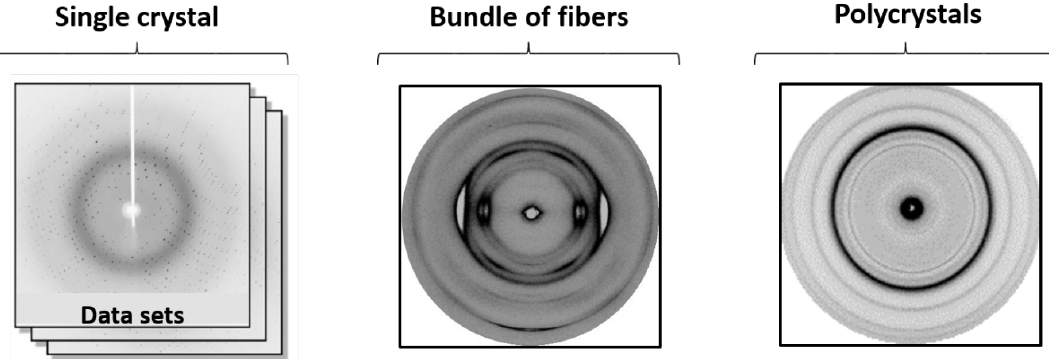
Figure 1. Typical diffraction patterns of single-crystal (left); bundle of fibers (center); poly-crystals (right). poly-crystals ( right